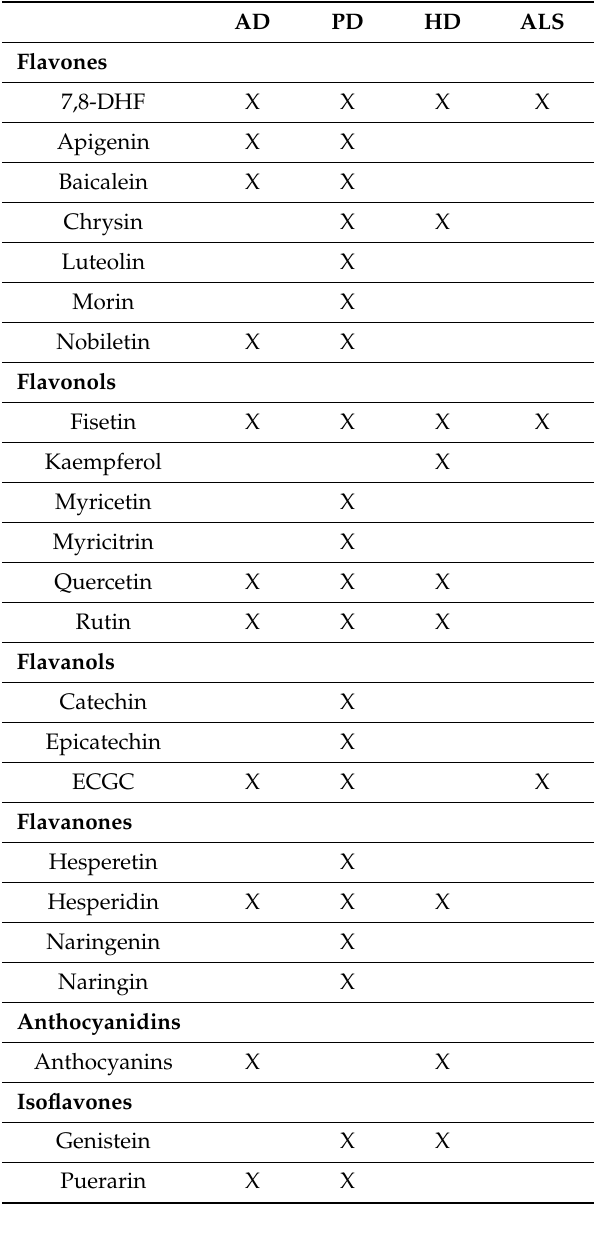
Table 1. Flavonoids that have shown e ffi cacy in preclinical models of Alzheimer’s disease (AD), Parkinson’s disease (PD), Huntington’s disease (HD), or amyotrophic lateral sclerosis (ALS).